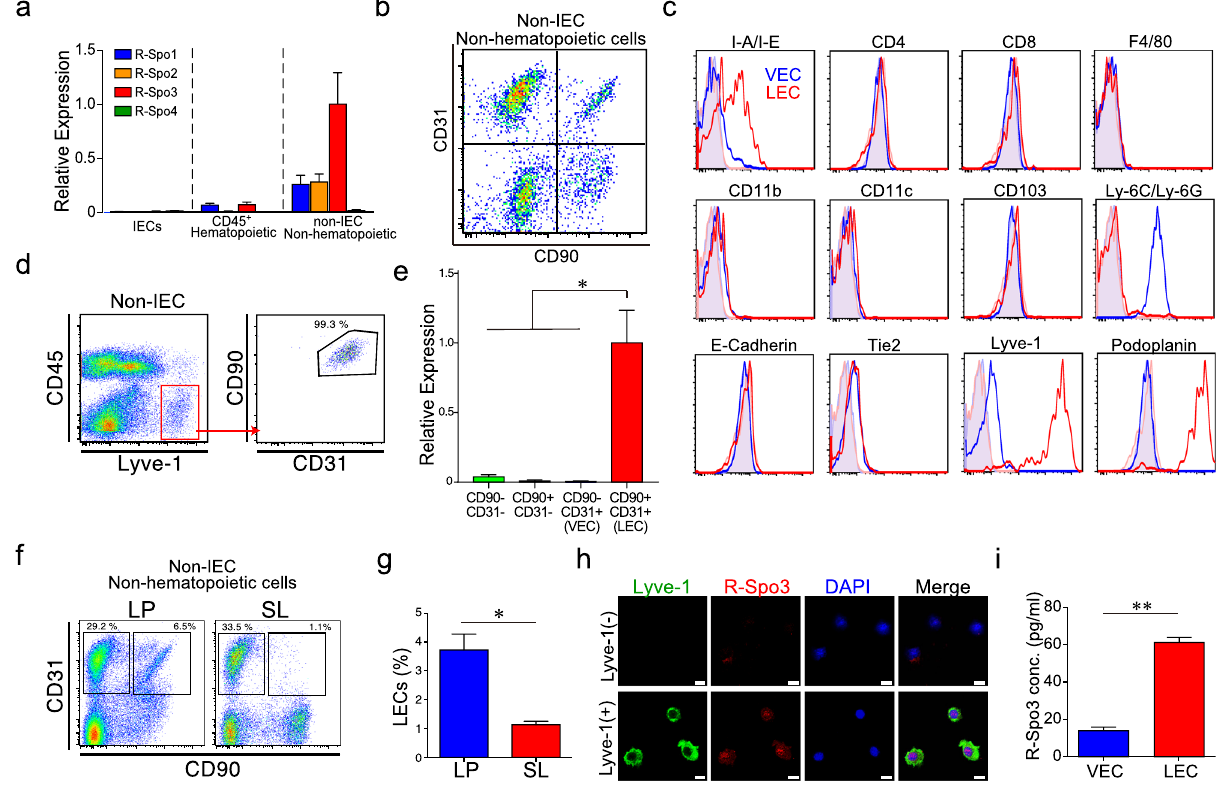
Figure 2. CD45 − CD90 + CD31 + LECs in the small intestine produce R-Spo3. ( a ) After IECs were harvested from the small intestine of naïve B6D2F1 mice by incubating with EDTA, CD45 + hematopoietic cells and CD45 − non-IEC non-hematopoietic cells were purified. The relative expressions of R-Spo genes normalized to that of 18S rRNA in each population was measured by quantitative PCR. Data from two independent experiments with similar results were combined and shown as the means ± SE of n-fold difference relative to the expression of R-Spo3 of non-IEC non-hematopoietic cells (n = 12/group). ( b ) Representative FACS plot of CD31 and CD90 expression on CD45 − cells from the small intestine. ( c ) Flow cytometric analysis of surface markers on CD45 − CD31 + CD90 − VECs (blue histograms) and CD45 − CD31 + CD90 + LECs (red histograms) from the small intestines. Shaded histograms represent unstained controls. ( d ) Expression of CD31 and CD90 was evaluated on gated CD45 − Lyve-1 + cells in the small intestine. ( e ) Expression levels of R-Spo3 in each population shown in ( b ). Data from one of two independent experiments with similar results are shown as the means ± SE (n = 4/group). ( f , g ) Lamina propria (LP) and the serosal layer (SL) of the small intestine were mechanically separated. Representative dot plots ( f ) and percentage ( g ) of LECs among CD45 − non- IEC non-hematopoietic cells are shown. Data from two independent experiments with similar results were combined and shown as the means ± SE in ( f ) (n = 6/group). ( h ) LECs were sorted from the small intestines. Immunofluorescent staining of Lyve-1 (green) and R-Spo3 (red) with nuclear staining with DAPI (blue) was performed. CD45 − Lyve-1 − cells were stained as controls. Scale bar, 10 μ m. ( i ) The concentration of R-Spo3 in the cell lysates from 3 × 10 5 sorted VECs, and LECs was measured using ELISA. Data from one of three independent experiments with similar results are shown as the means ± SE (n = 4/group). * P < 0.05, ** P <